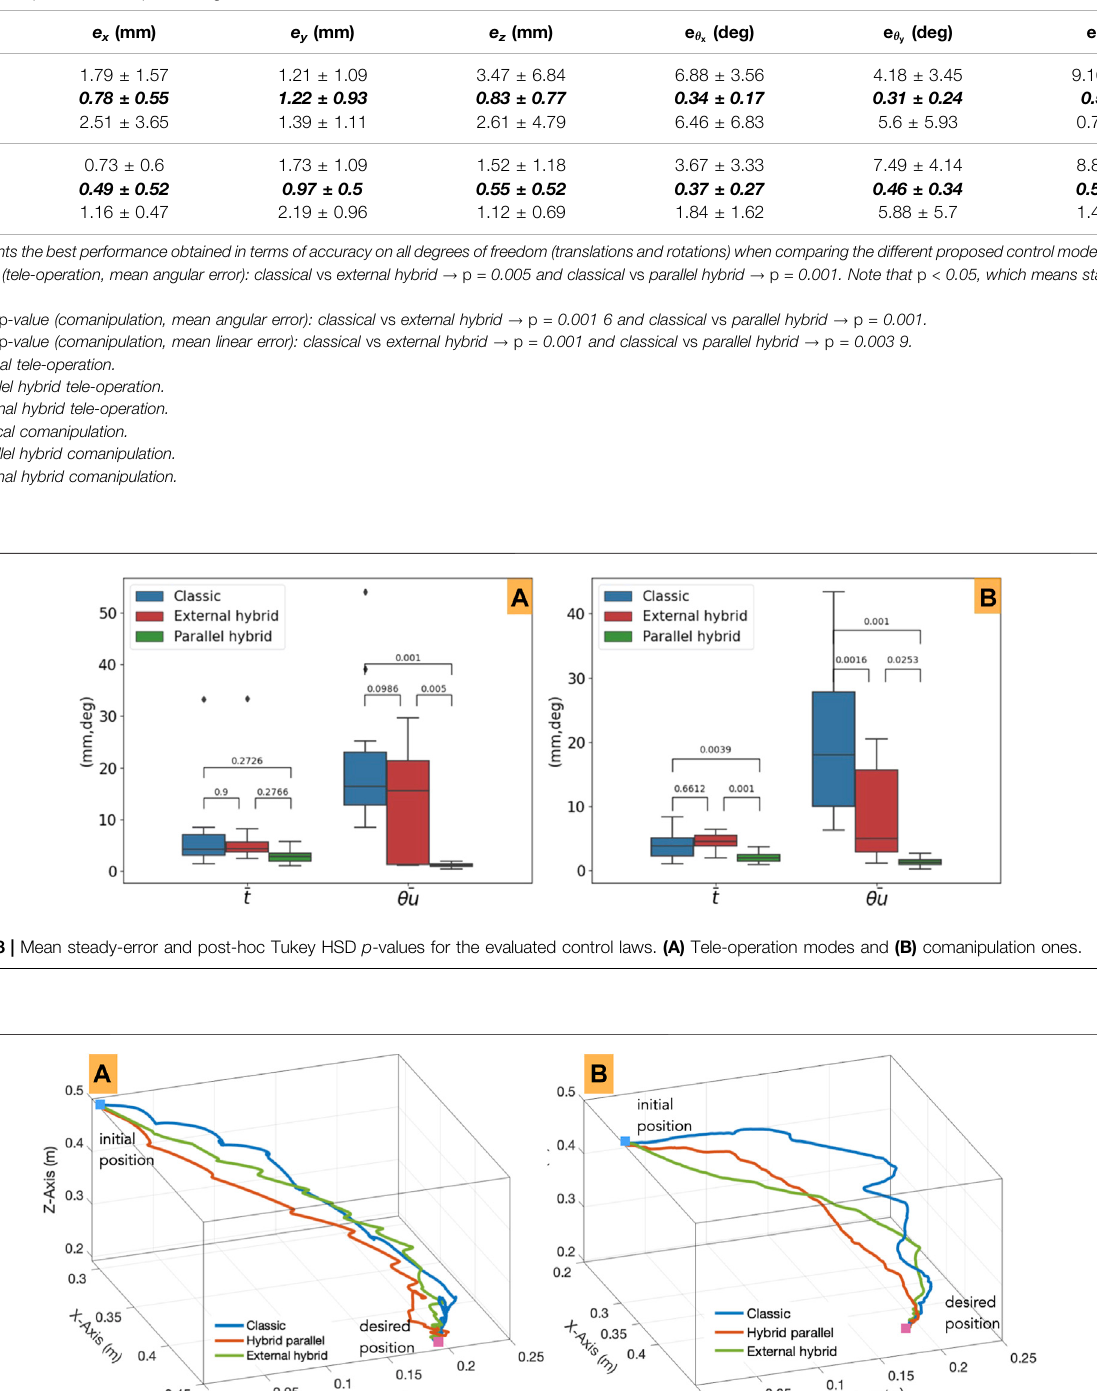
TABLE 1 | Comparison of the positioning errors obtained with different control modes.